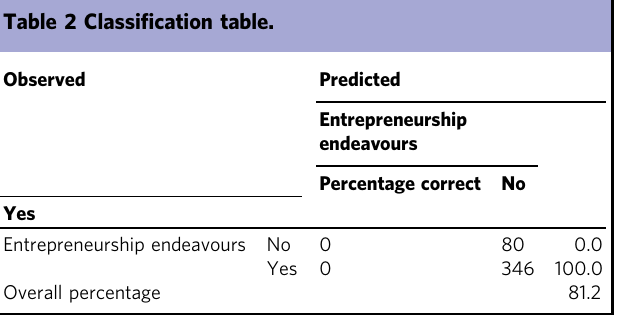
Table 2 Classi fi cation table.